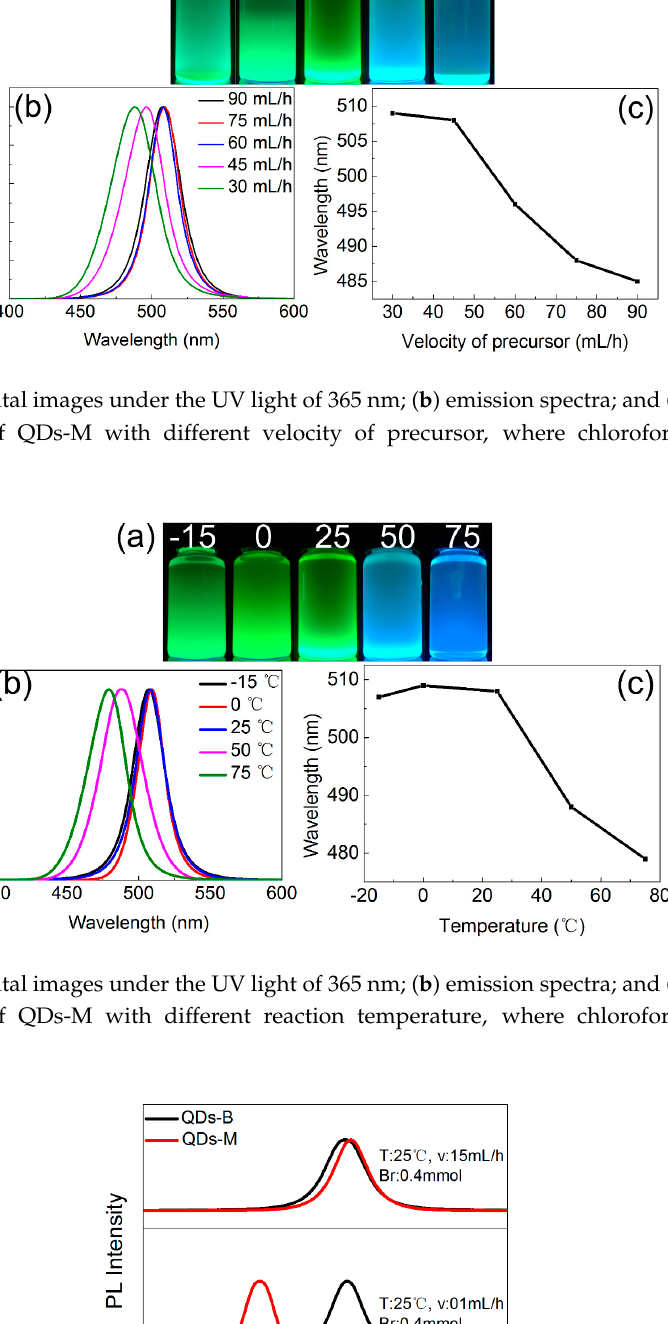
statistical chart of QDs-M with different dosage of PbBr 2 , where toluene is used as nonpolar solvent.